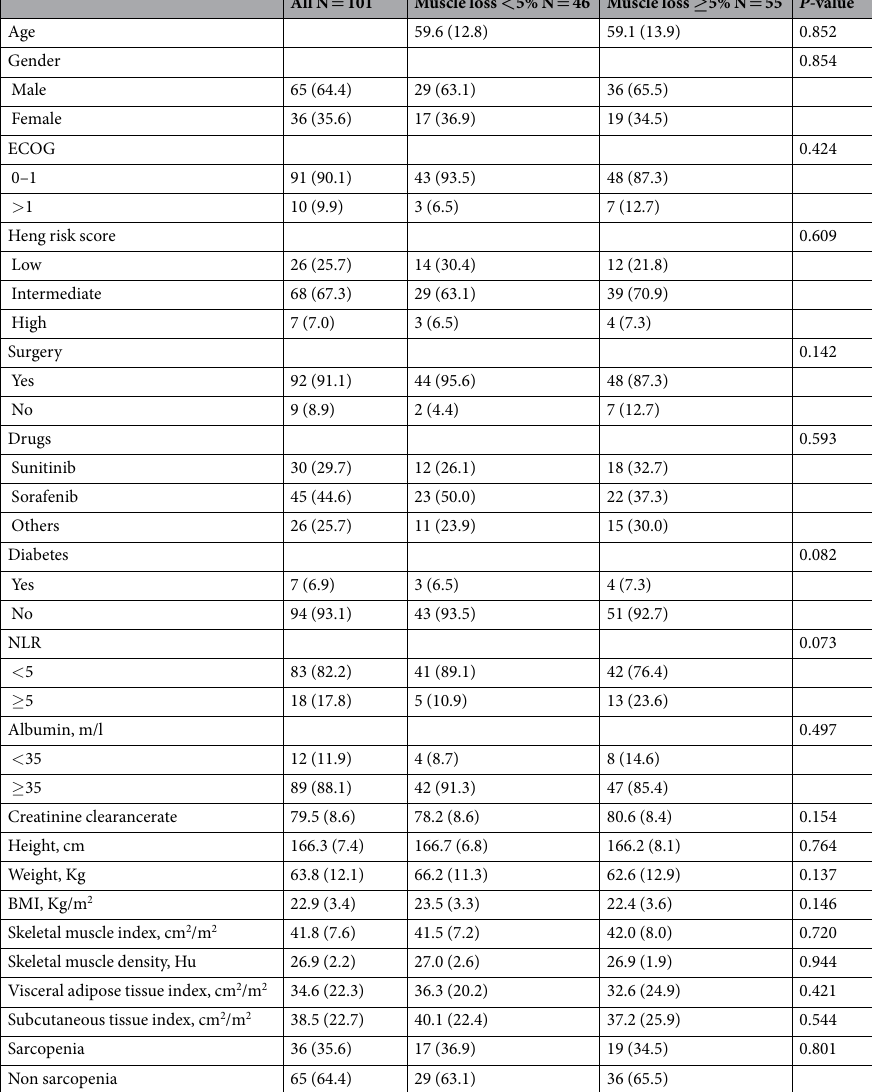
Table 1. Baseline Clinical Characteristics. Abbreviation: BMI body mass index; NLR: Neutrophil to lymphocyte ratio; ECOG Eastern Cooperative Oncology Group Performance Status.